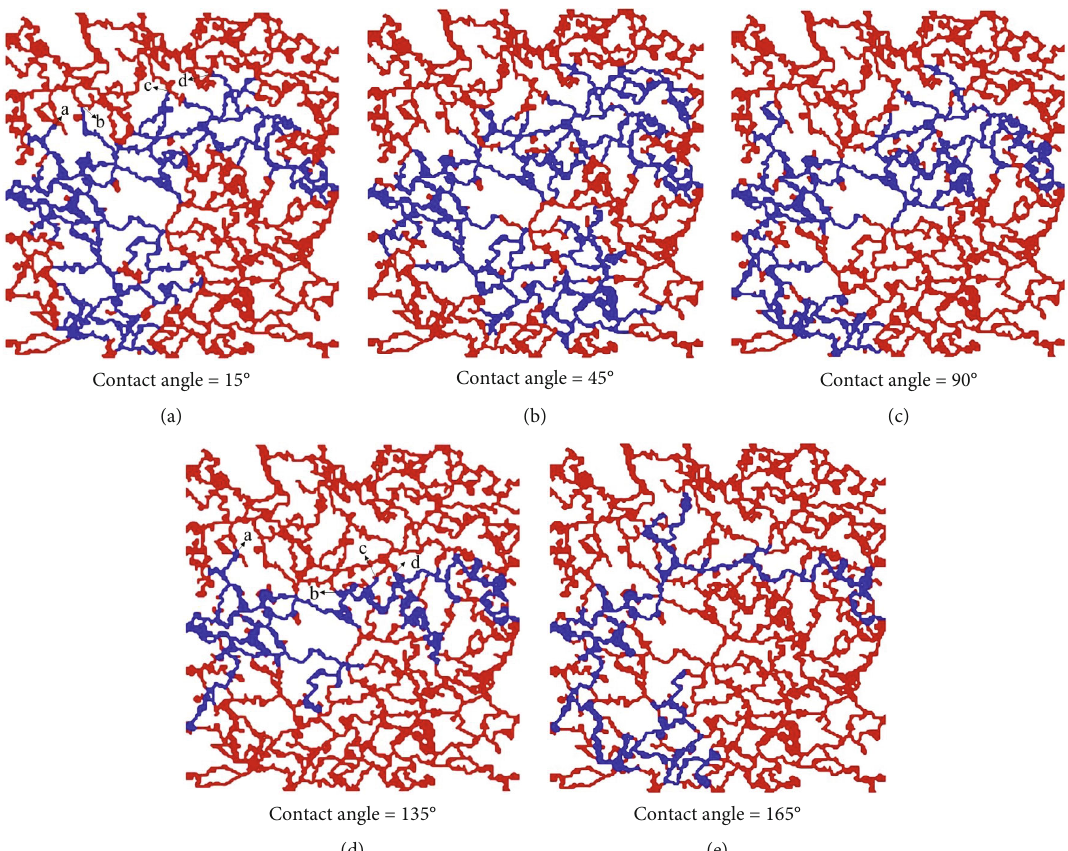
Figure 10: Oil and water two-phase distribution versus contact angle. (a) Contactangle = 15 ° . (b) Contactangle = 45 ° . (c) Contactangle = 90 ° . (d) Contactangle = 135 ° . (e) Contactangle = 165 ° .